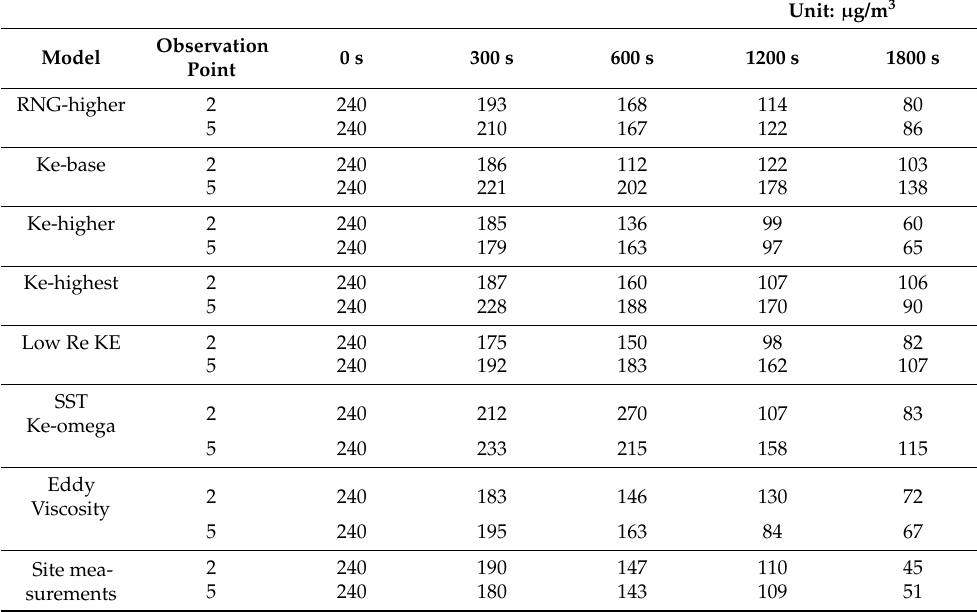
Table 3. Part of the site measurements and simulation